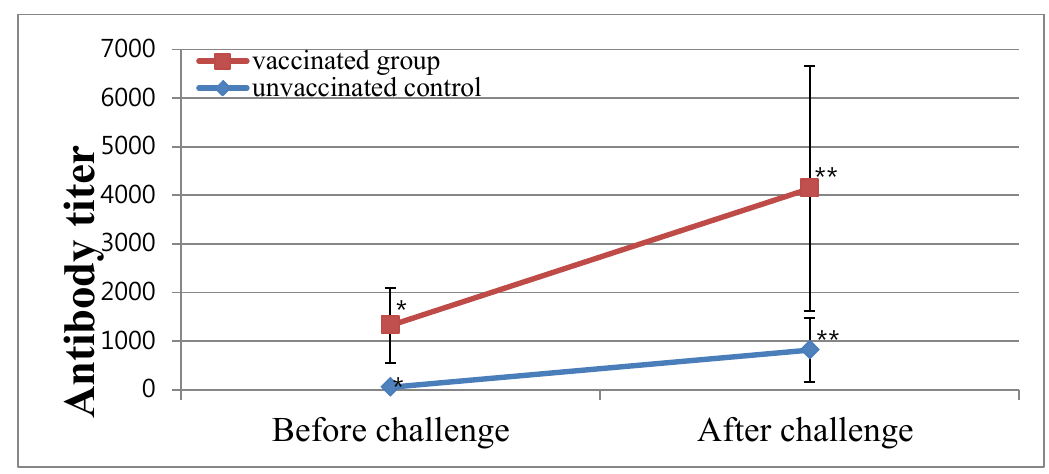
Figure 4. Mean enzyme-linked immunosorbent assay (ELISA) antibody titers before and after challenge in experimental chickens vaccinated with an inactivated IB oil vaccine at 13-week-old and challenged with IBV SNU8067 3 weeks later. The sera were collected at 5 weeks after challenge. The levels of antibody titers between the control and vaccinated groups after vaccination and challenge were significantly different ( P <